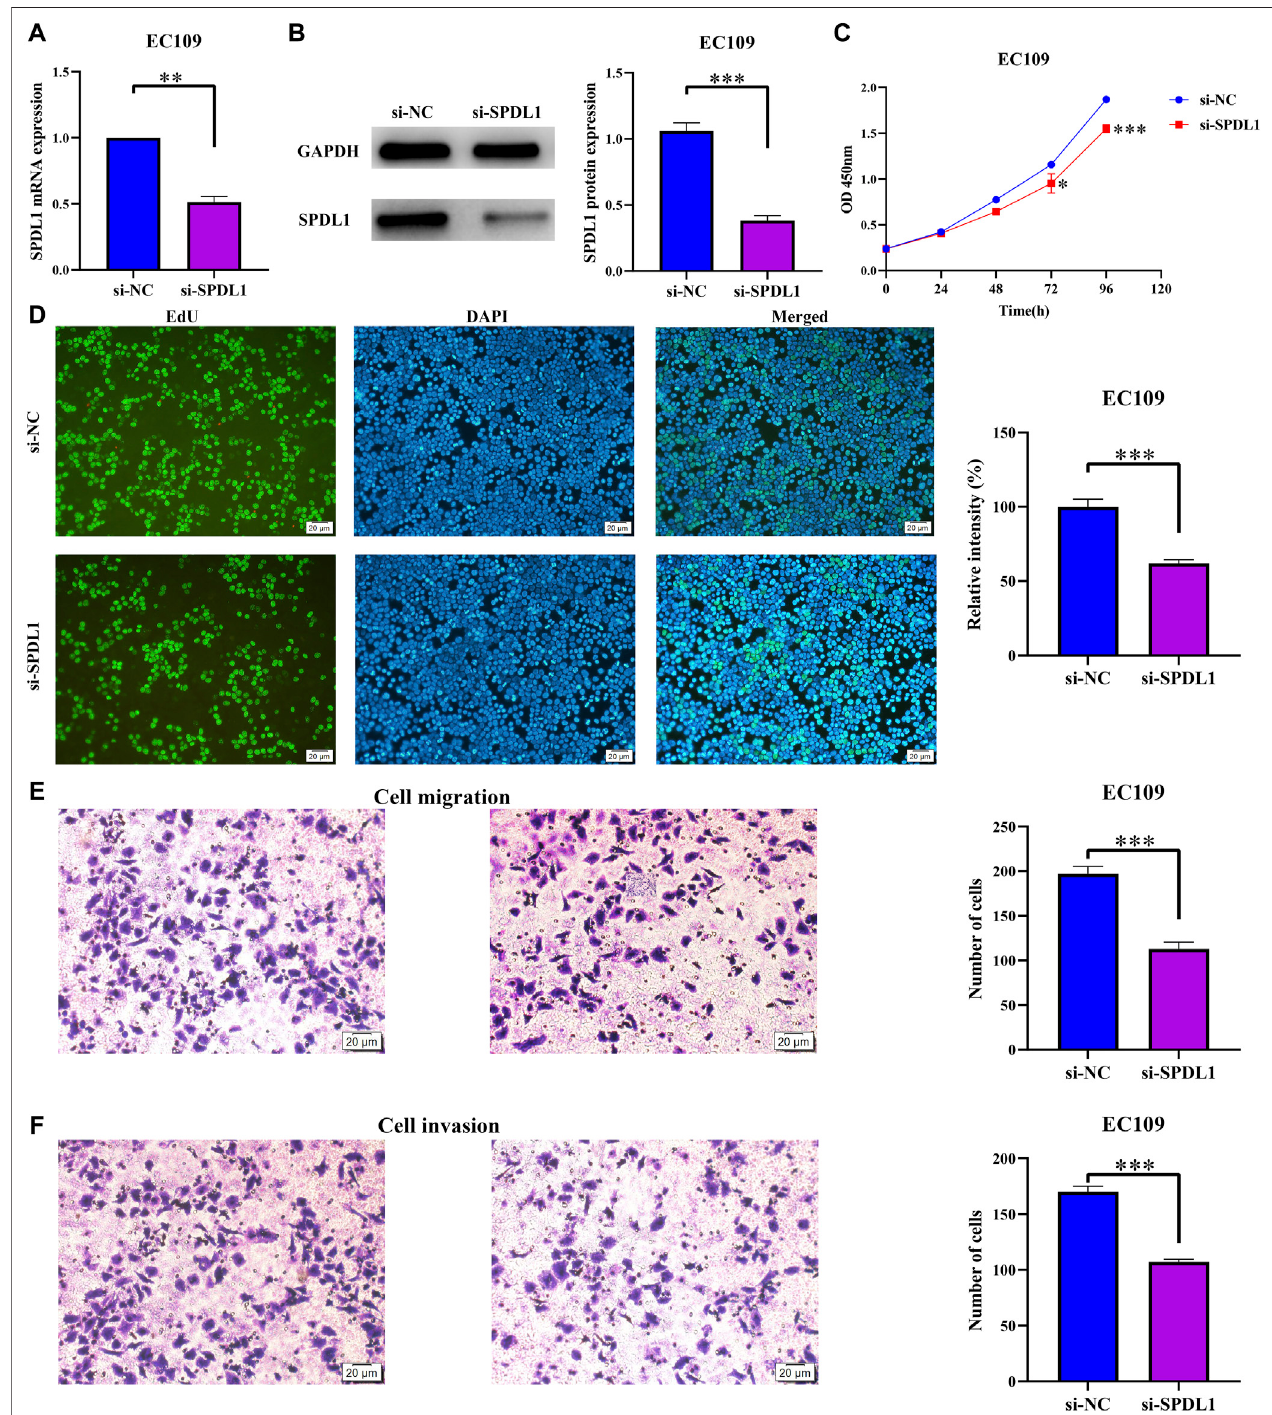
FIGURE9| SPDL1 silencing inhibitsESCA cellgrowthand migration. (A,B) EstablishmentofESCAcellmodel; (C,D) cellproliferationdetermined viaCellCounting Kit-8 and Edu methods and (E,F) cell migration and invasion determined using Transwell assays. ESCA, esophageal cancer; SPDL1, spindle apparatus coiled-coil protein